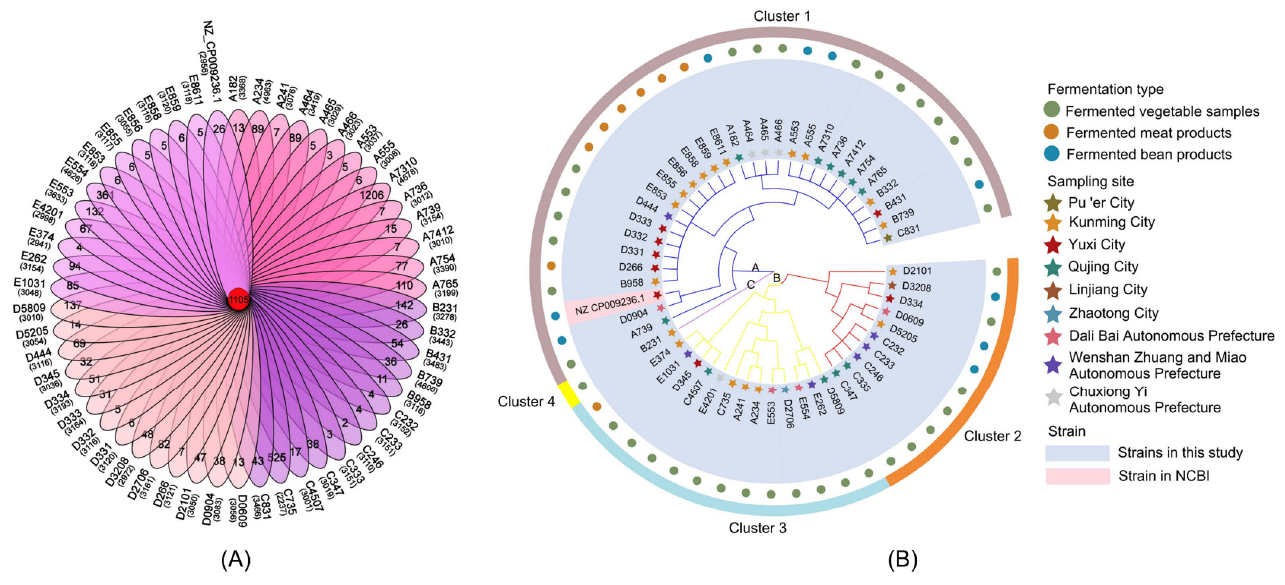
Figure 6. Homology analysis and phylogenetic analysis of Lactobacillus plantarum . ( A ) Venn diagram presenting the homology analysis of 54 strains of L. plantarum ; ( B ) phylogenetic tree construction of 54 strains of L. plantarum based on homologous genes.